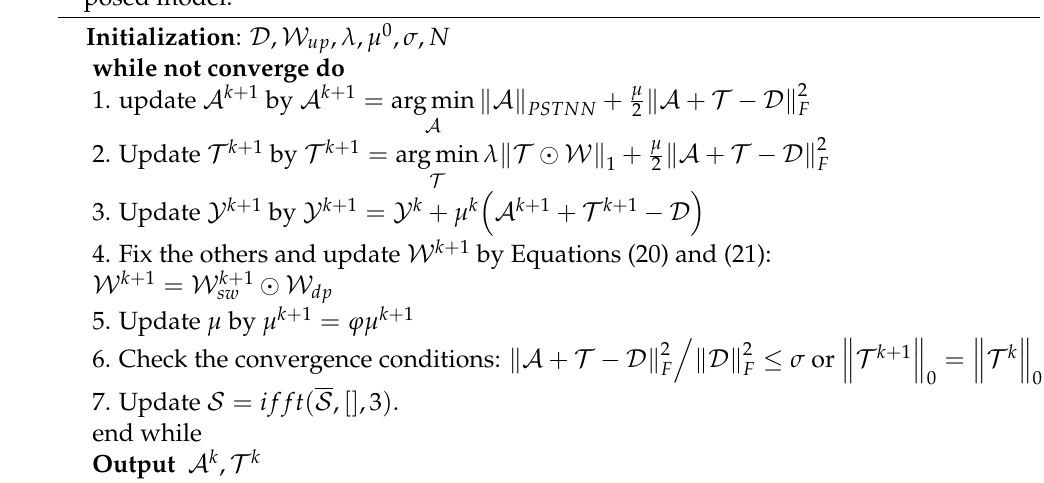
Figure 5. Flowchart of the model presented in this paper. Algorithm 2: Flow chart of the algorithm solution. ADMM solver to the pro- posed